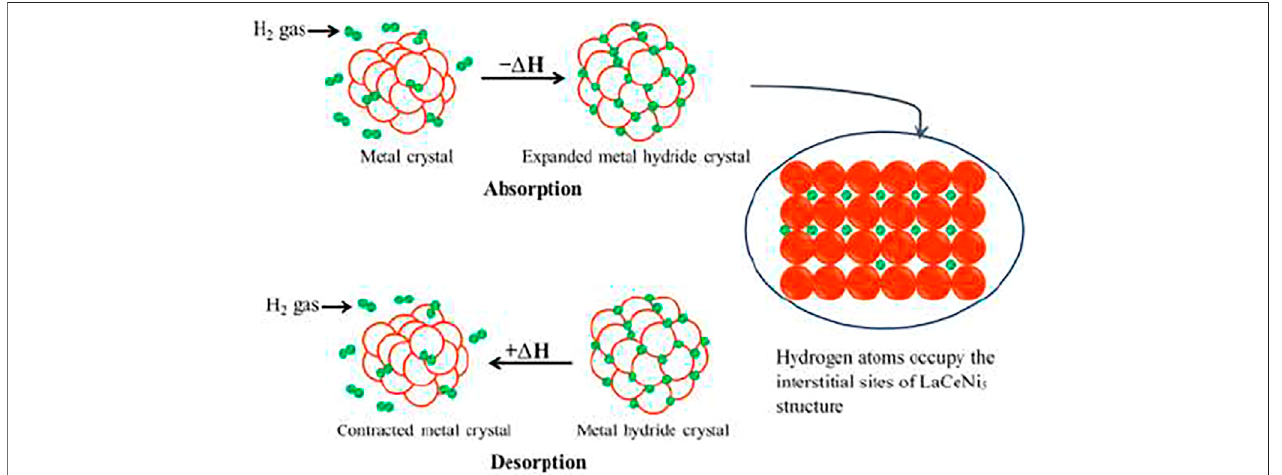
FIGURE 6 | Adsorption and desorption mechanism of metal powder in a metal hydride storage tank.